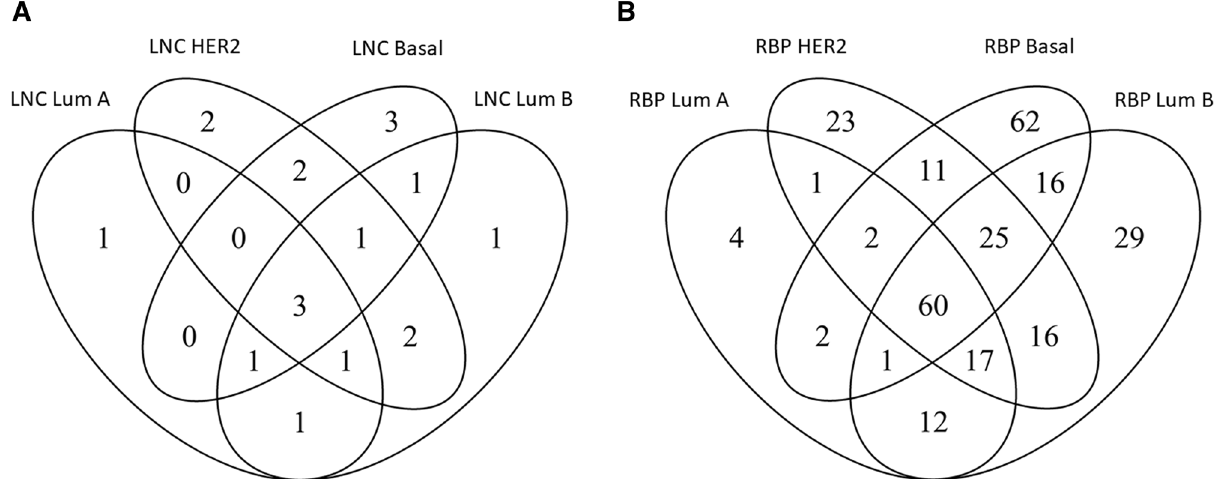
Figure 2. Venn diagram. It identifies: ( A ) common differentially expressed long non-coding RNAs (lncRNAs) and ( B ) RNA-binding proteins (RBPs) among breast cancer molecular